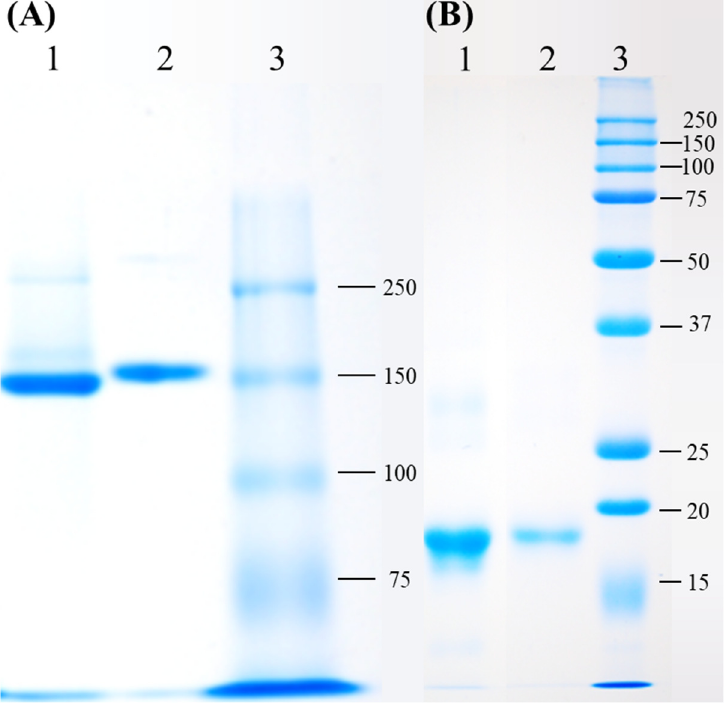
Figure 1. Detection of the purified phycoerythrin (PE) of Colaconema sp. via ( A ) native PAGE and ( B ) SDS-PAGE. Native and SDS gels electrophoresis were run in 8% and 15% gel, respectively. ( A )